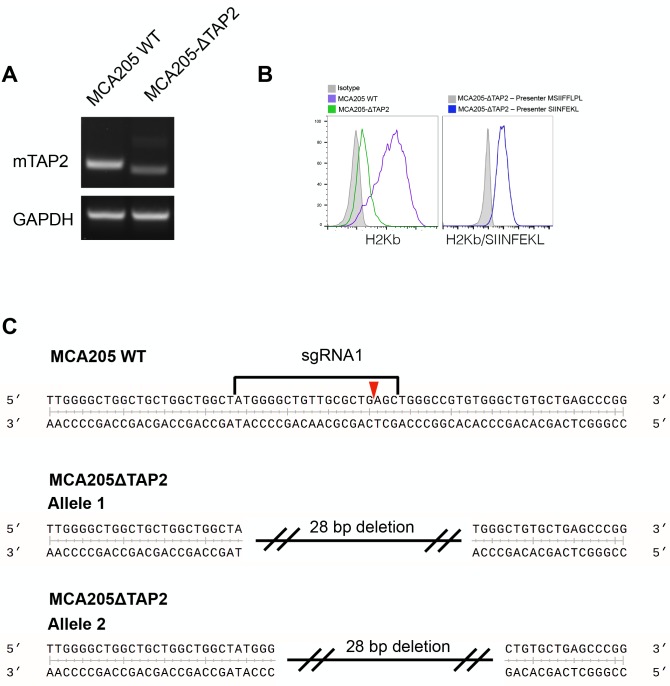
MCA205ΔTap2 cell line was generated by transient transfection of MCA205 cells with a plasmid encoding Cas9 and an sgRNA directed at Tap2.A single cell clone with an INDEL in both alleles of Tap2 was selected and expanded. (A) RT-PCR of genomic DNA shows a smaller band than wild-type cells. (B) Left: Loss of surface H2-Kb in the ΔTap2 line. Right: transduction of MCA205ΔTap2 with PresentER-SIINFEKL or PresentER-MSIIFFLPL and staining with SIINFEKL/H2-Kb TCR mimic antibody shows Tap independent presentation of the SIINFEKL antigen. (C) Next generation sequence of the MCA205ΔTap2 single cell clone shows two different 28 bp deletions in both Tap2 loci.